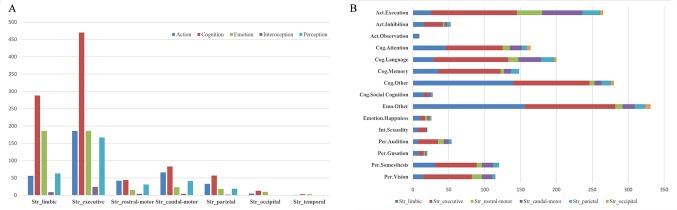
Behavior domains (BDs) and their subcategories associated with each striatal subregion in MACM analysis. (A) (left): histograms of the Brainmap-delineated BDs for each striatal subregion; (B) (right): the top 15 subcategories of BDs for all seven striatal subregions.